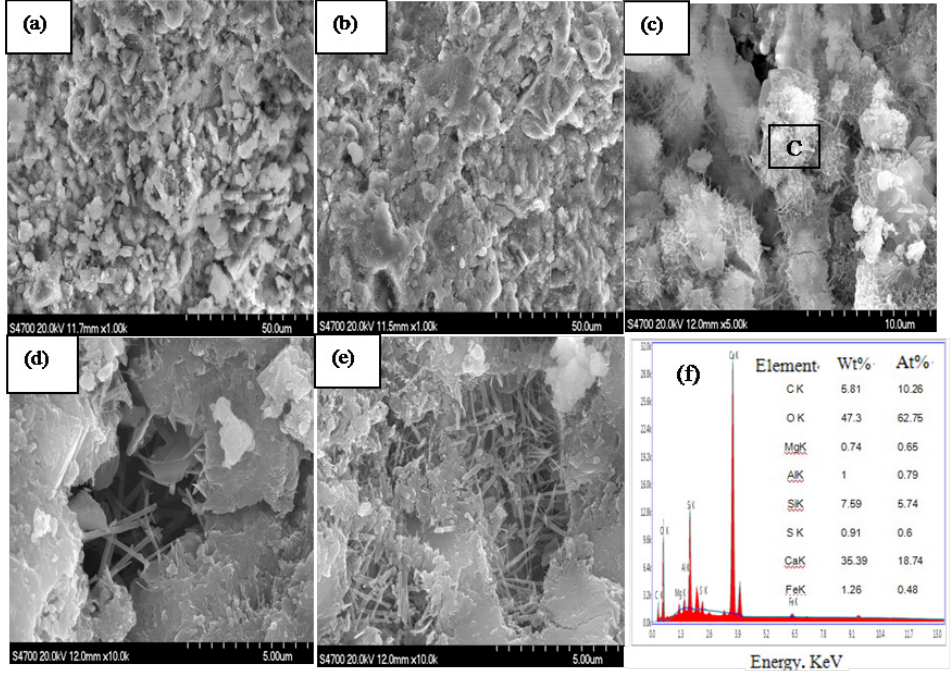
Fig. 7. SEM photos and EDS spectrum of hardened paste hydration for